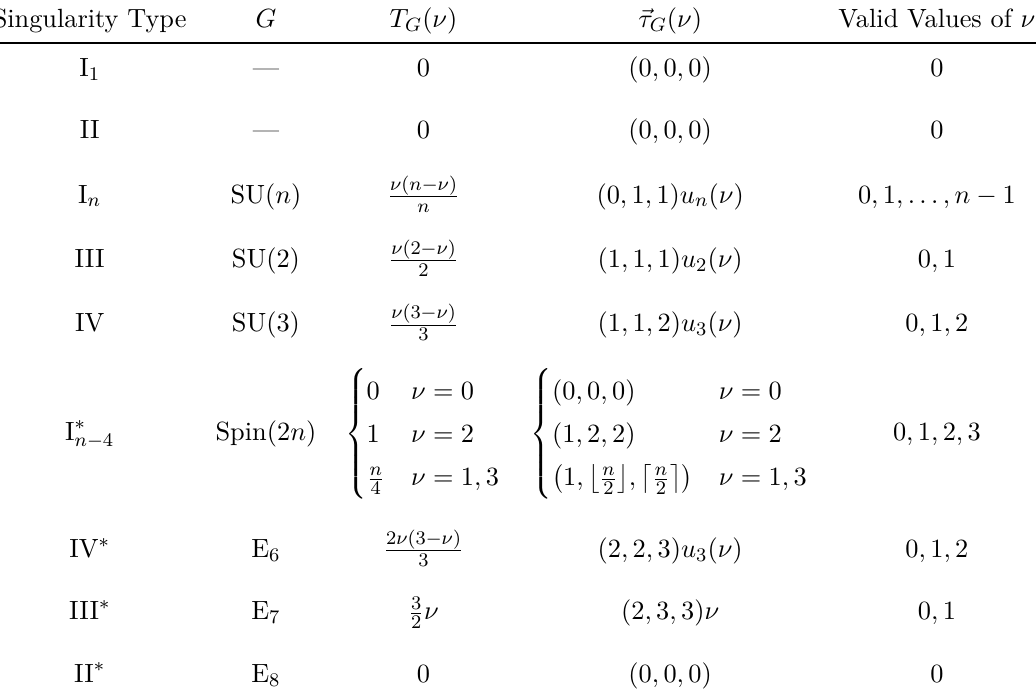
Table 1. Expressions for T G ( ν ) and ~τ G ( ν ) . While the singularity types I 1 and II do not have listed gauge group, G can be thought of as SU(1) in these situations. In this paper, we focus on the split versions of these singularity